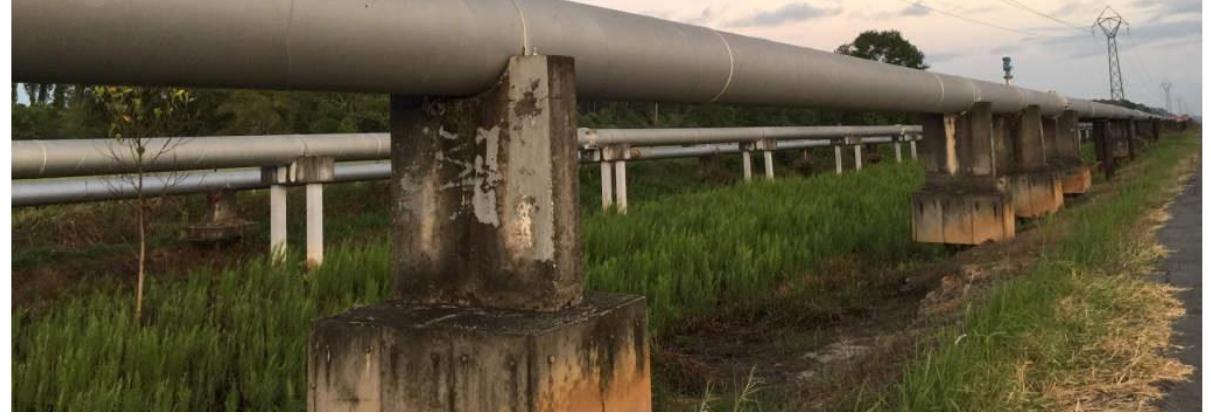
Figure A2. Pilings supporting water pipelines along Jalan Badas. Piles are exposed under pile caps due to peat